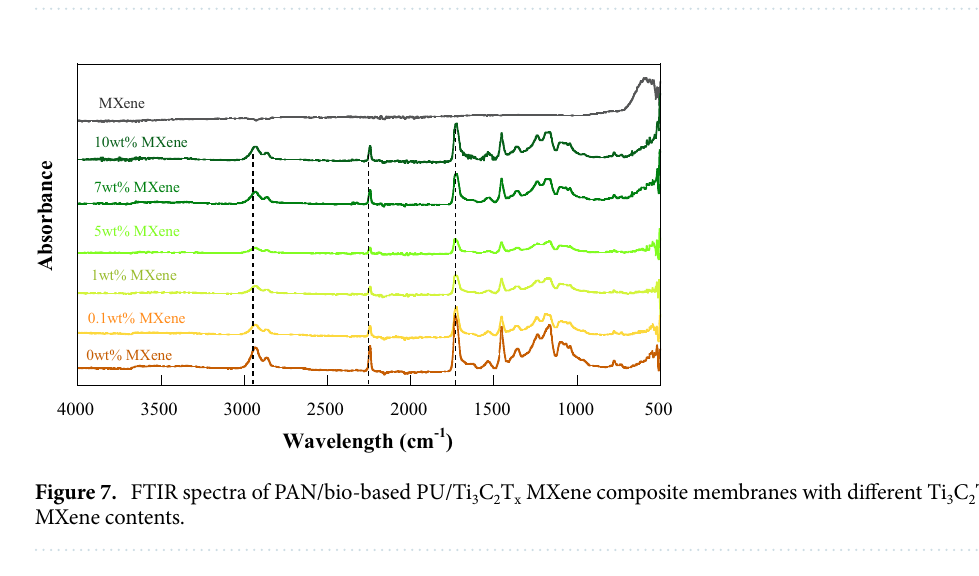
Figure 6. XRD patterns of ( a ) pure PAN/bio-based U and ( b ) PAN/bio-based PU with 10 wt% Ti 3 C 2 T x MXene.